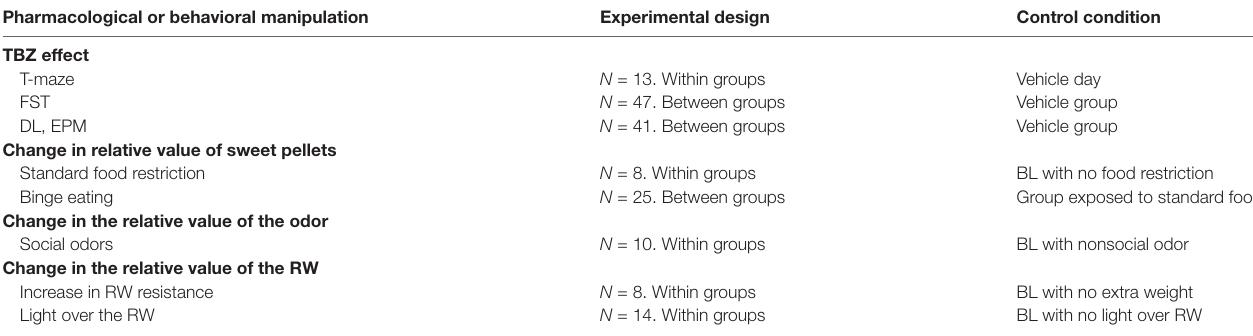
TABLE 1 | Experimental design and number of mice used in each experiment (FST, forced swim test; DL box, dark-light box; EPM, elevated plus